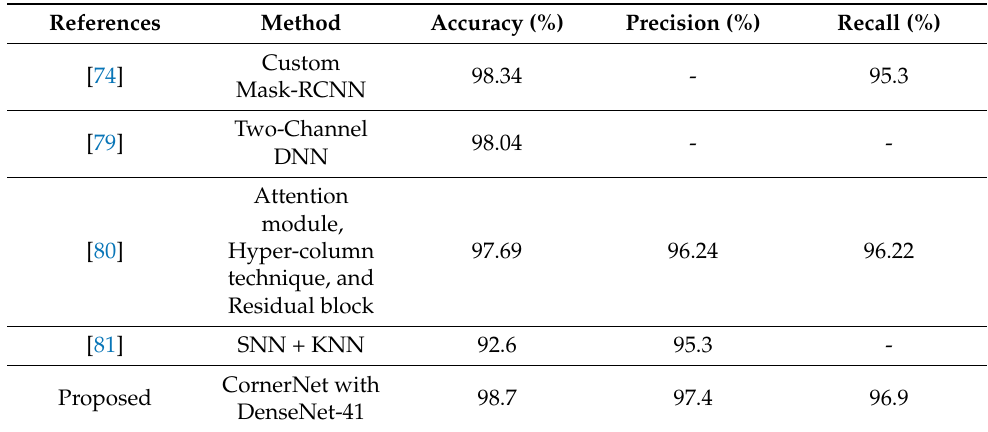
Table 6. Comparison with state-of-the-art